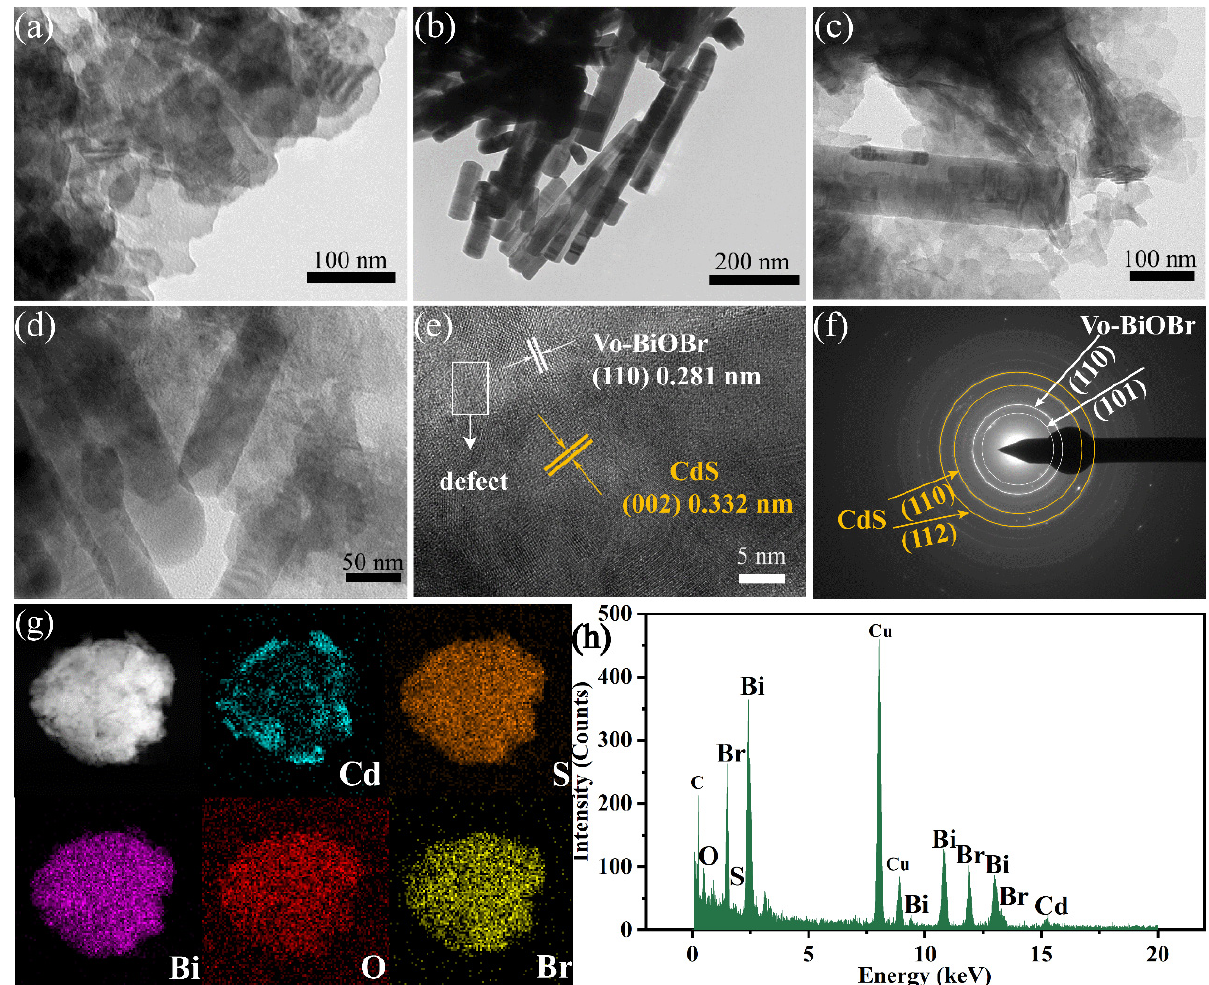
Figure 3. TEM images of Vo-BiOBr ( a ), CdS ( b ), and Vo-BiOBr/CdS ( c , d ); HRTEM image ( e ); SAED pattern ( f ); The elemental mapping ( g ), and EDX spectrum ( h ) of the Vo-BiOBr/CdS. The chemical composition of as-synthesized samples was evaluated by XPS measure- ment. Survey spectra from Figure 4a of Vo-BiOBr, CdS, and Vo-BiOBr/CdS demonstrate the presence of Bi, O, Br, S, and Cd elements in Vo-BiOBr/CdS. The high-resolution XPS spectra of Bi 4f, Br 3d, O 1s, Cd 3d, and S 2p for the samples are presented in Figure 4b–f. The spectra of Bi 5f exhibited two peaks at 158.78 eV and 164.08 eV (Figure 4b), which can be ascribed to Bi 4f 7/2 and Bi 4f 5/2 , respectively, demonstrating the presence of Bi 3+ . As for Br 3d (Figure 4c), two peaks located at 67.88 eV and 68.93 eV, can be ascribed to Br 3d 5/2 and Br 3d 3/2 , respectively, indicating the chemical states of Br − . In Figure 4d, the spectra of O 1s can be fitted with three peaks at 529.38 eV, 530.83 eV, and 532.33 eV inferring lattice oxygen (Bi-O), oxygen vacancies, and absorbed oxygen, respectively [44]. It is worth noting that Vo-BiOBr/CdS had a larger area for the characteristic peak representing the oxygen vacancy than BiOBr (Table S1), suggesting that the reduction of ethylene glycol is vital to forming Vo. More significantly, the peaks of Bi 4f, Br 3d, and O 1s of Vo-BiOBr moved toward lower binding energy compared with BiOBr (Figure S2), which proved that